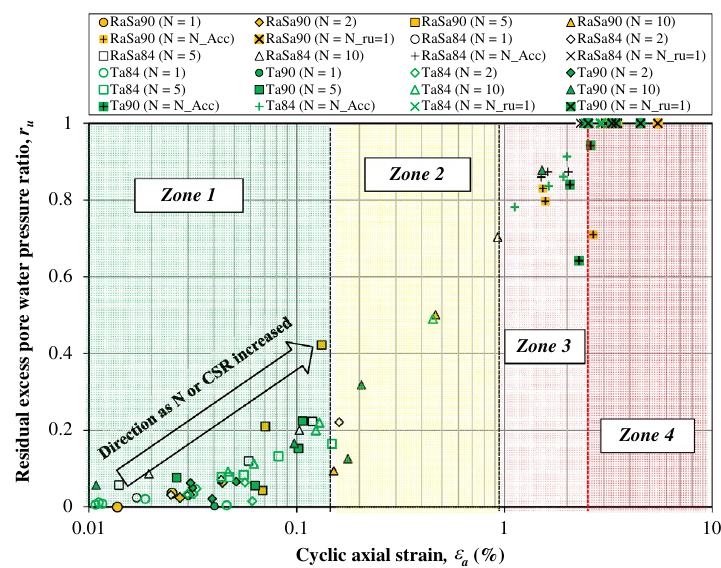
Cyclic axial strain (cid:31) , a (%) Fig. 10 Excess pore water pressure build-up versus cyclic axial strain of all prepared samples (both tailings and railway sand